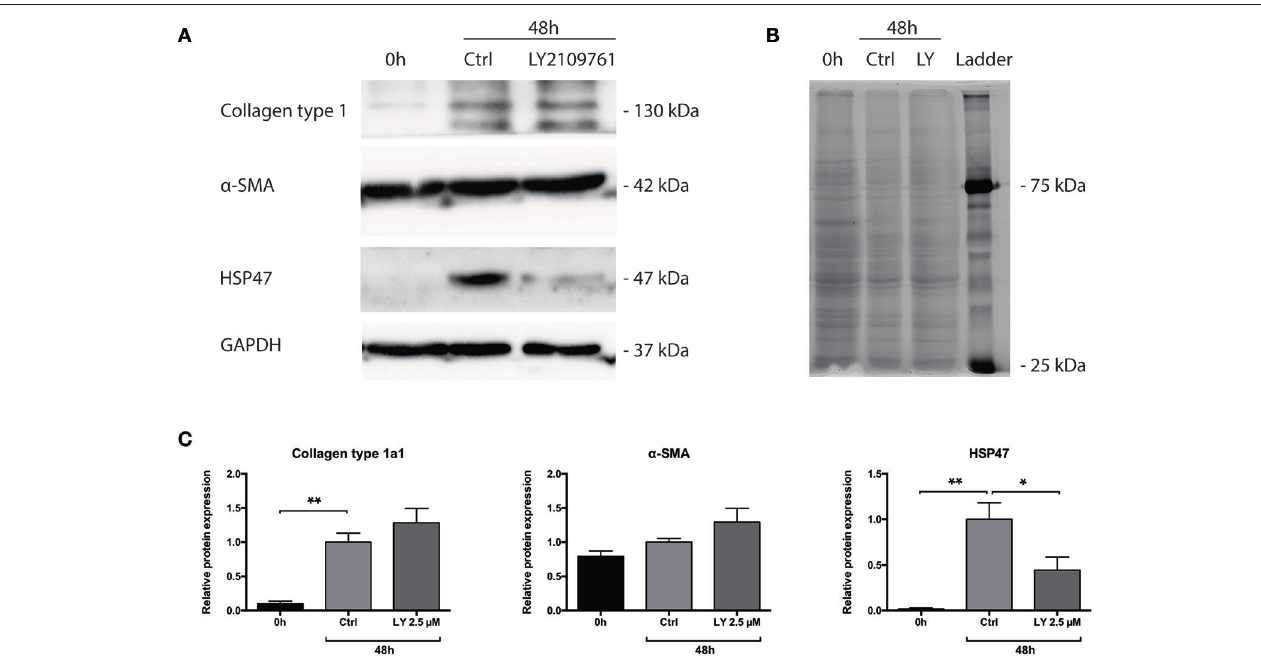
FIGURE 5 | Protein levels of Collagen type 1 alpha 1, HSP47 and α -SMA of PCKS at 0h, 48h and treated with LY2109761, a TGF- β receptor type I/II (T β RI/II) dual inhibitor. (A) Representative Western blot images of Collagen type 1 alpha 1, HSP47, α -SMA and GAPDH. (B) Total protein stain with 2,2,2-trichloroethanol. (C) Quantification of detected proteins, after correction for total protein content. * p < 0.05, ** p < 0.001. Data is expressed as mean ( ± SEM), n = 4. α -SMA, alpha smooth muscle actin; HSP47, heat-shock protein 47; kDa, kilodalton; LY, LY2109761.